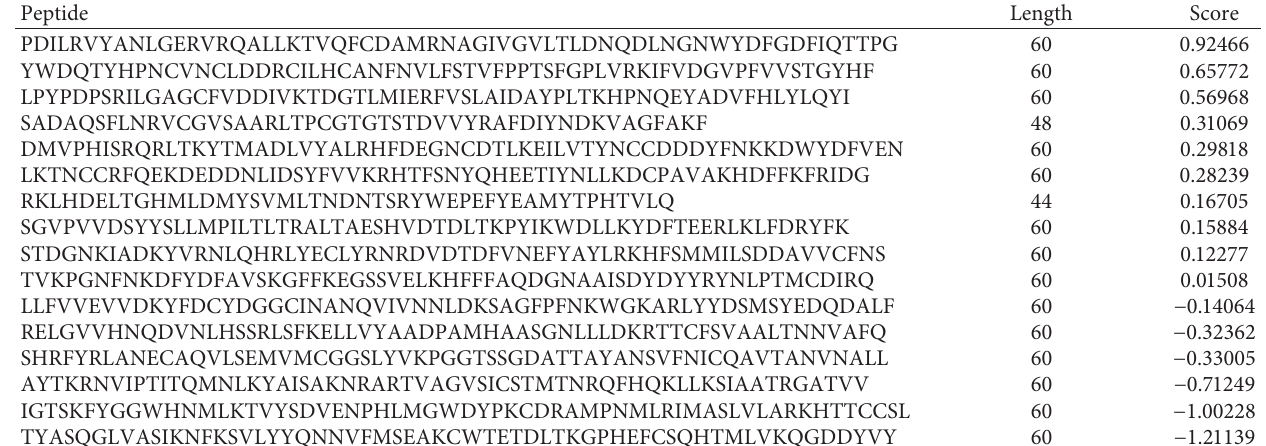
Table 4: Class I immunogenicity of RdRp protein of SARS-CoV-2. Peptide